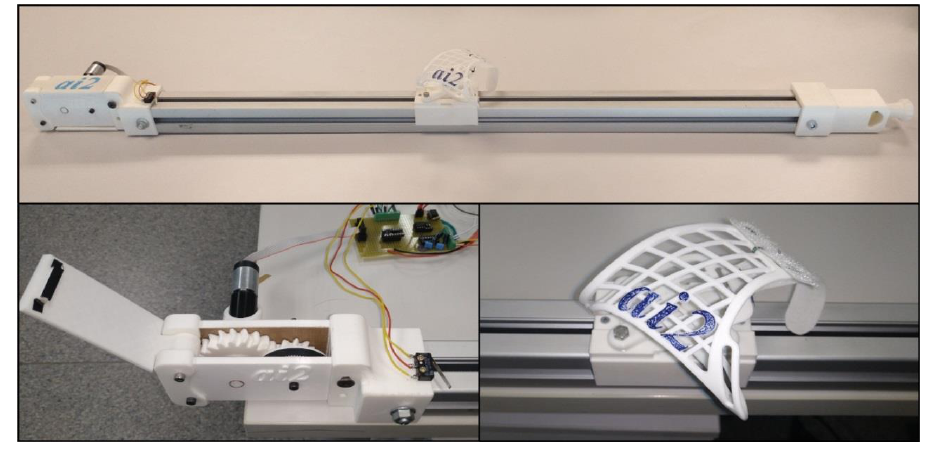
Figure 2. Rehabilitation guide.